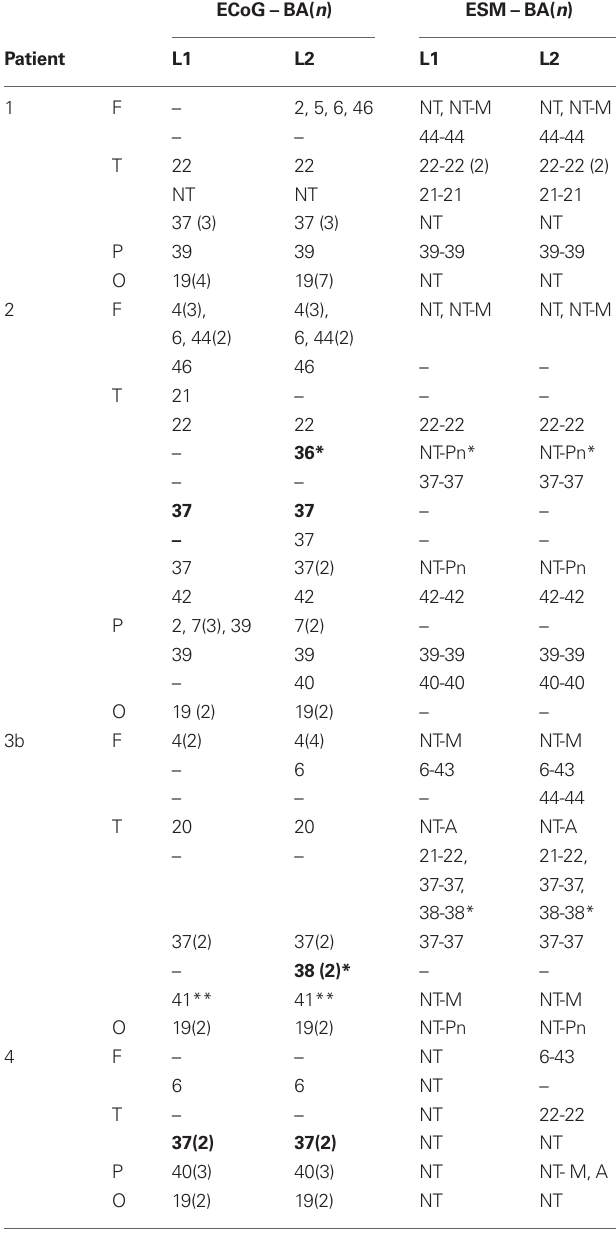
Table 4 | Location of L1 and L2 ECoG spectral responses and ESM results by Brodmann area